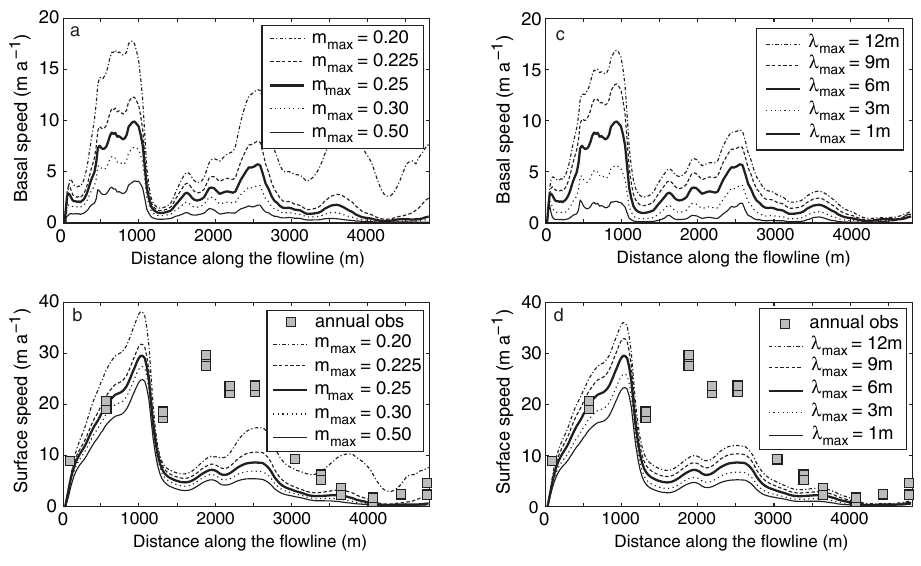
Fig. 5. Sensitivity of modelled flow speeds to friction-law parameters m max and λ max for simulations with basal water pressure set equal to zero. (a) Basal- and (b) surface flow speeds modelled for m max = 0 . 2–0 . 5 and λ max = 6m. (c) Basal- and (d) surface flow speeds modelled for λ max = 1–12m and m max = 0 . 25. A = 2 . 4 × 10 − 24 Pa − 3 s − 1 for these simulations, and solid squares in (b) and (d) indicate measured annual flow